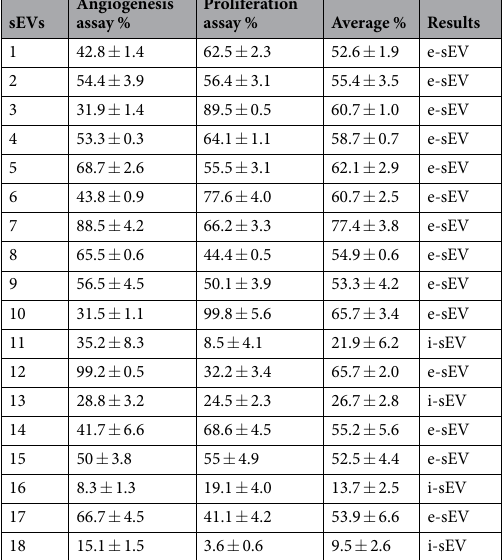
Table 1. Proangiogenic in vitro effects of different sEV samples. 18 sEV samples evaluated by in vitro angiogenesis assay and in vitro proliferation assay on ECs. The average represents the mean value of results of both assays ± SD (see Methods). sEVs with an average value exceeding 50% have been considered effective sEVs (e-sEVs) otherwise they are ineffective